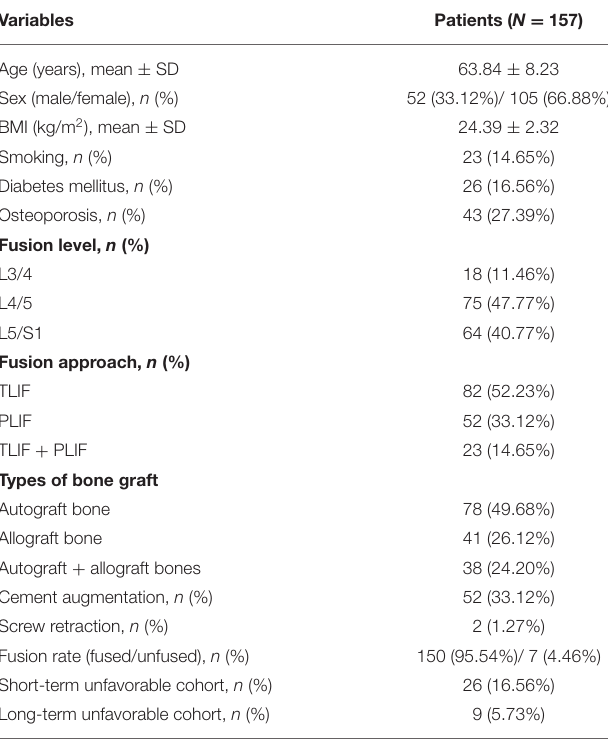
TABLE 1 | Demonstrative information of the patient cohort.